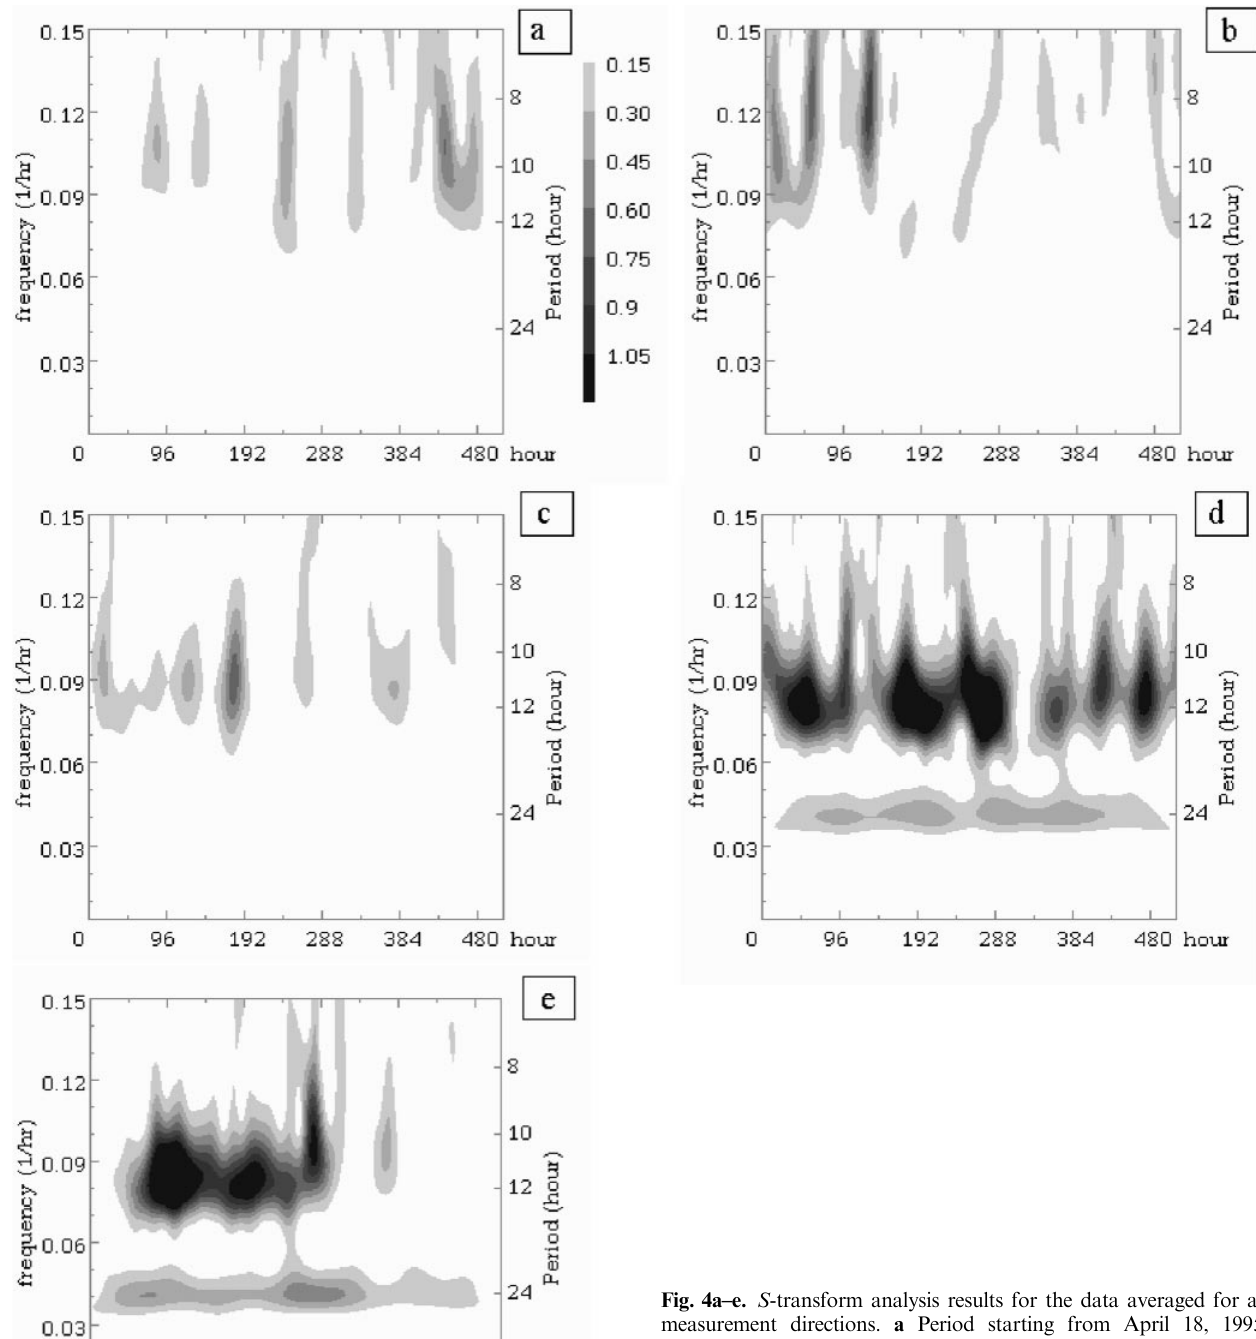
Fig. 4a–e. S -transform analysis results for the data averaged for all measurement directions. a Period starting from April 18, 1995; b period starting from July 28, 1995; c period starting from September 4, 1995; d period starting from November 19, 1995; e period starting from February 1, 1995. The amplitudes of oscillations in relative units is shown in the shades of